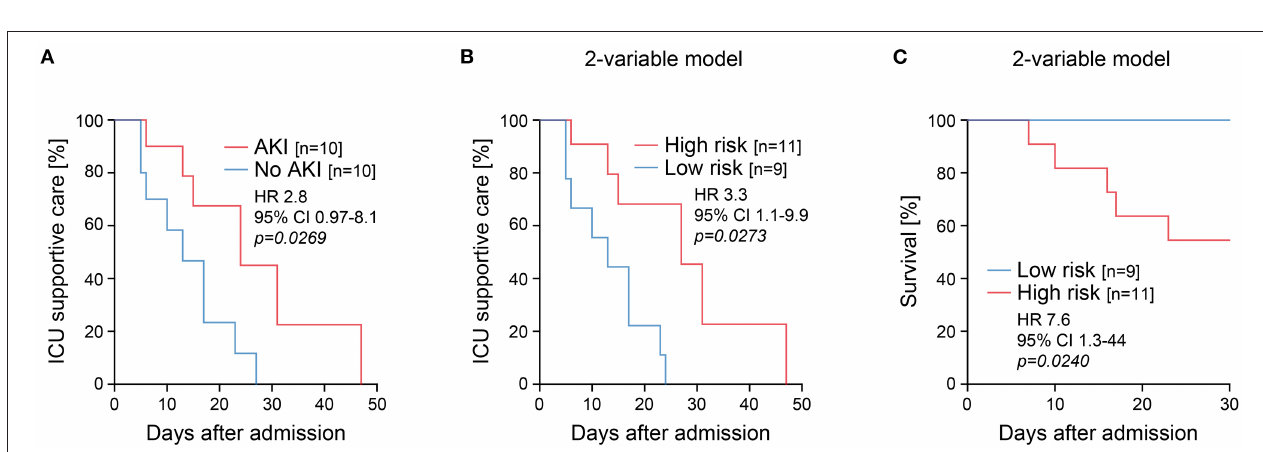
FIGURE 3 | Combining urinary SARS-CoV-2N and plasma albumin measurements identifies patients at risk for AKI. (A) ROC analysis for combining urinary SARS-CoV-2N and plasma albumin measurements at ICU admission (two-variable model) for association with AKI in COVID-19. (B) Frequency and survival analysis for cumulative incidence of AKI after group separation for established two-variable model. AKI, acute kidney injury; AUC, area under the curve, CI: confidence interval; HR, hazard ratio; ROC: receiver operator curve; SARS-CoV-2N, severe acute respiratory syndrome coronavirus 2 nucleocapsid protein.